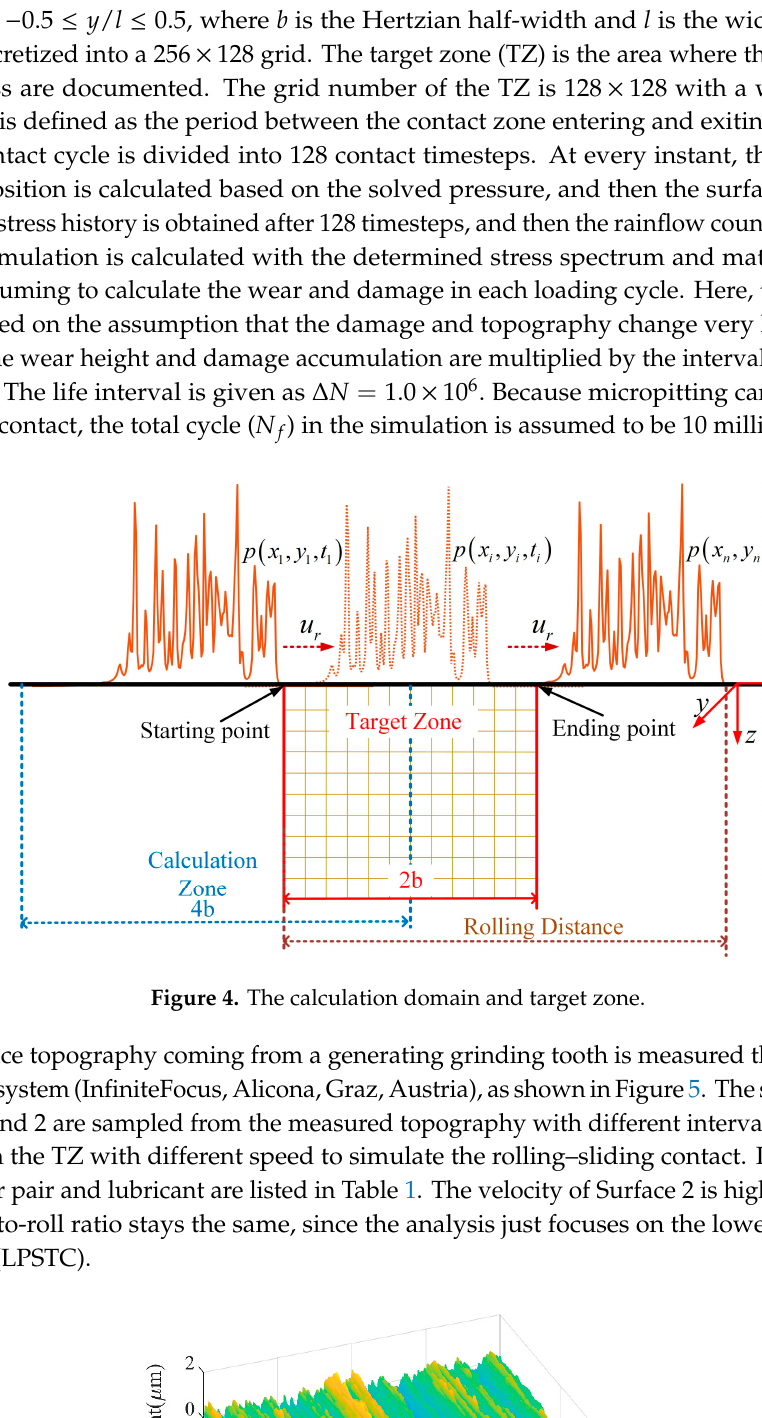
Figure 5. The ground tooth surface topography.